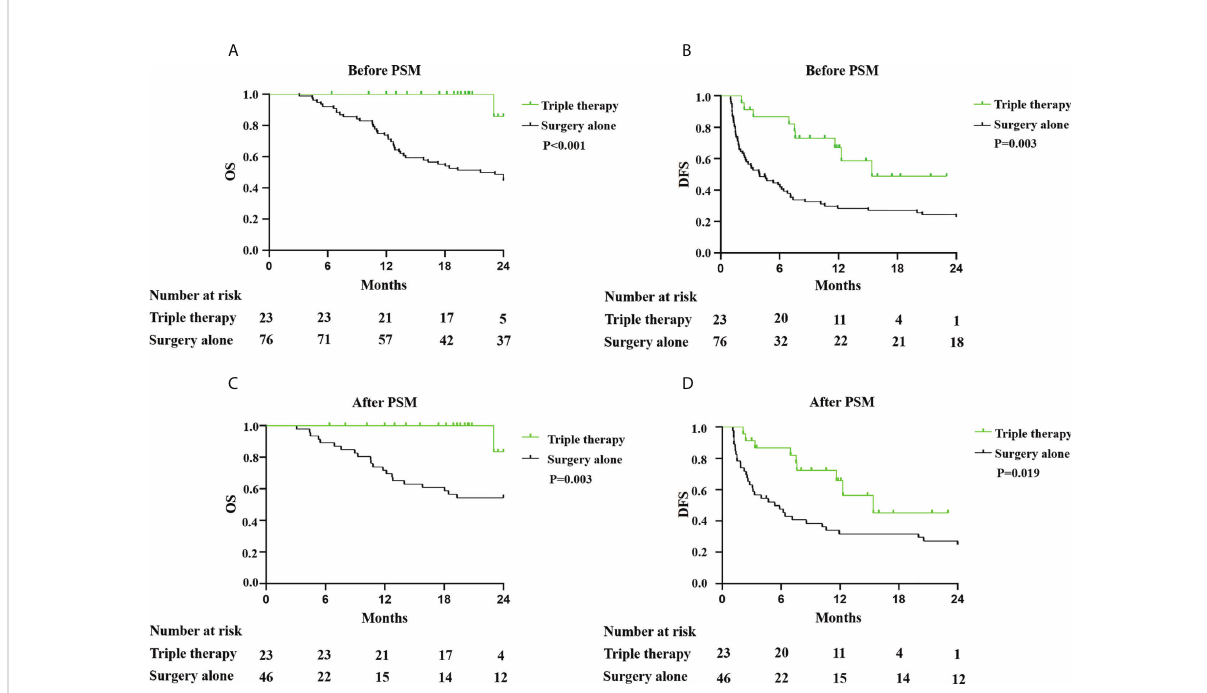
FIGURE 3 Kaplan – Meier analysis of OS and DFS in patients with HCC with high risk of recurrence treatment with triple therapy or surgery alone. (A) OS and (B) DFS in patients with HCC with and without triple therapy before PSM. (C) OS and (D) DFS in patients with HCC with and without triple therapy after PSM.